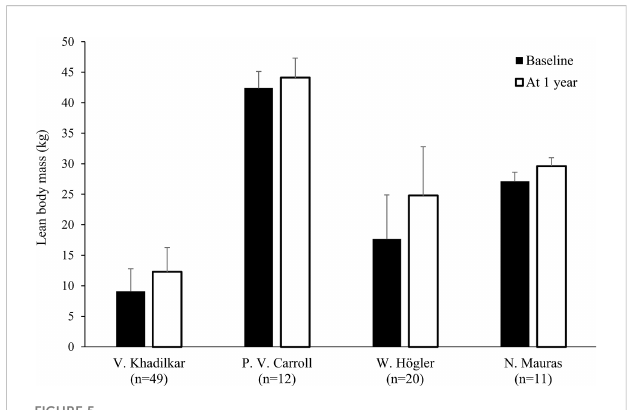
FIGURE 5 Lean body mass (mean kg with standard deviation) at baseline and after 1 year a of rhGH replacement in patients b with GHD (18, 22, 24, 27). a Two months of replacement in Mauras et al. b Carroll et al. enrolled a post-pubertal population. GHD, growth hormone de fi ciency, rhGH, recombinant human growth hormone.